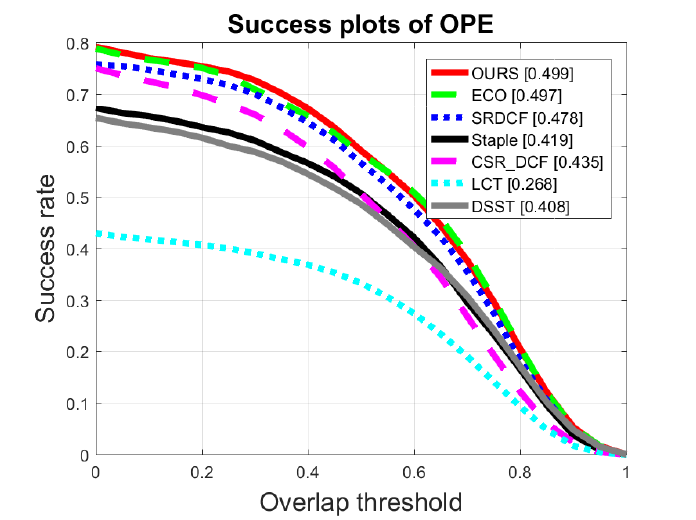
Figure 8. Comparison of Success plots with 7 trackers on